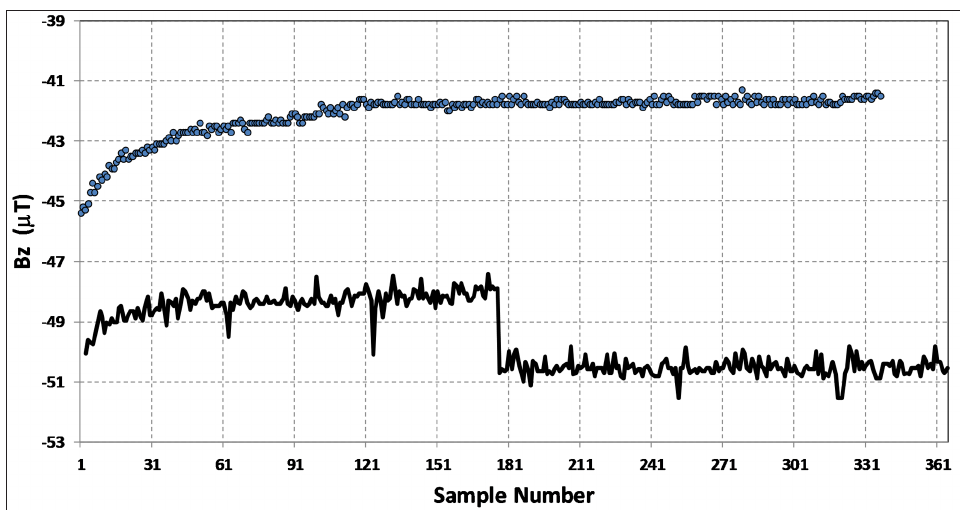
Figure 2: Glitch artifacts, DC level jumps, and asymptotic settling seen in side-by-side tests of the iPhone and Samsung platforms. Samsung data (solid line), iPhone data (dots). Credit Odenwald